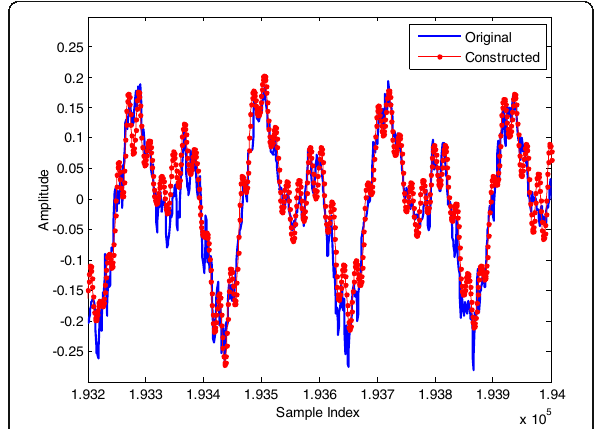
Fig. 4 Waveform comparison of the reconstructed audio and the original audio. The plot shows a detailed part of the es01 audio